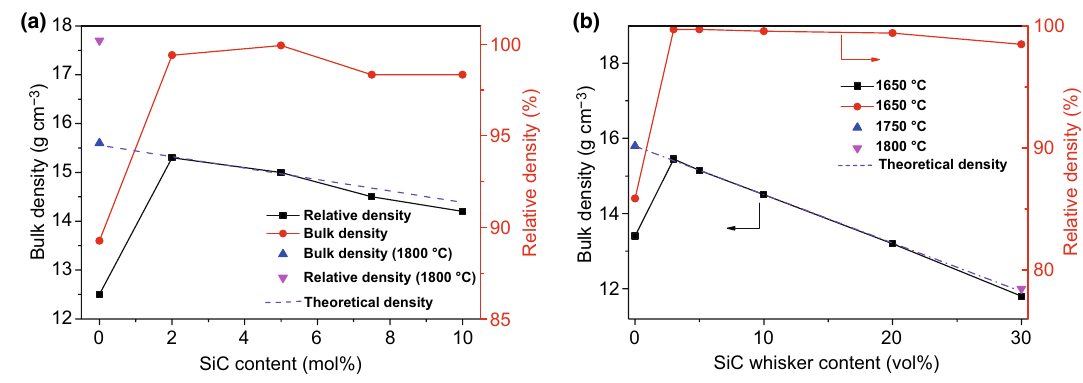
Fig. 5 a Bulk density and relative density of WC–SiC composites [87]. b Bulk density and relative density of WC–SiC w composites [88]. Figure panels reproduced from Ref. [87] with permission from Japan Institute of Metals (JIM) copyright 2011, Ref. [88] with permission from Japan Institute of Metals (JIM) copyright